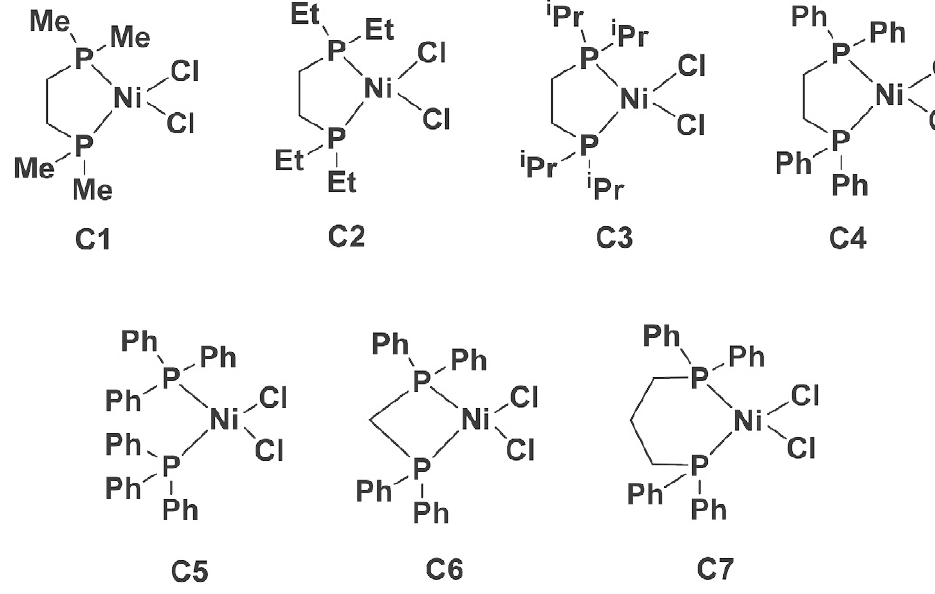
Figure 1: Nickel(II)diphosphine complexes used in the current